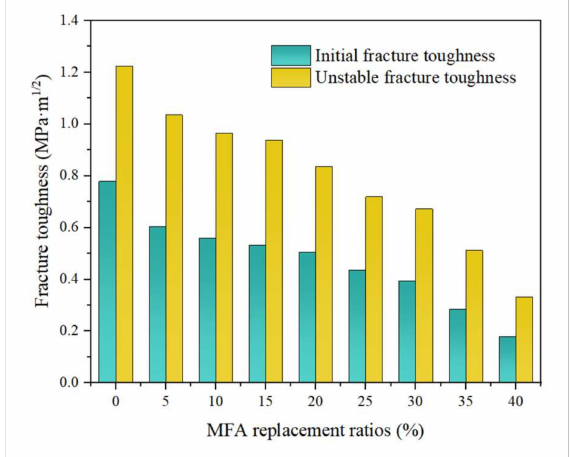
Figure 10. Initial and unstable fracture toughness with different MFA replacement